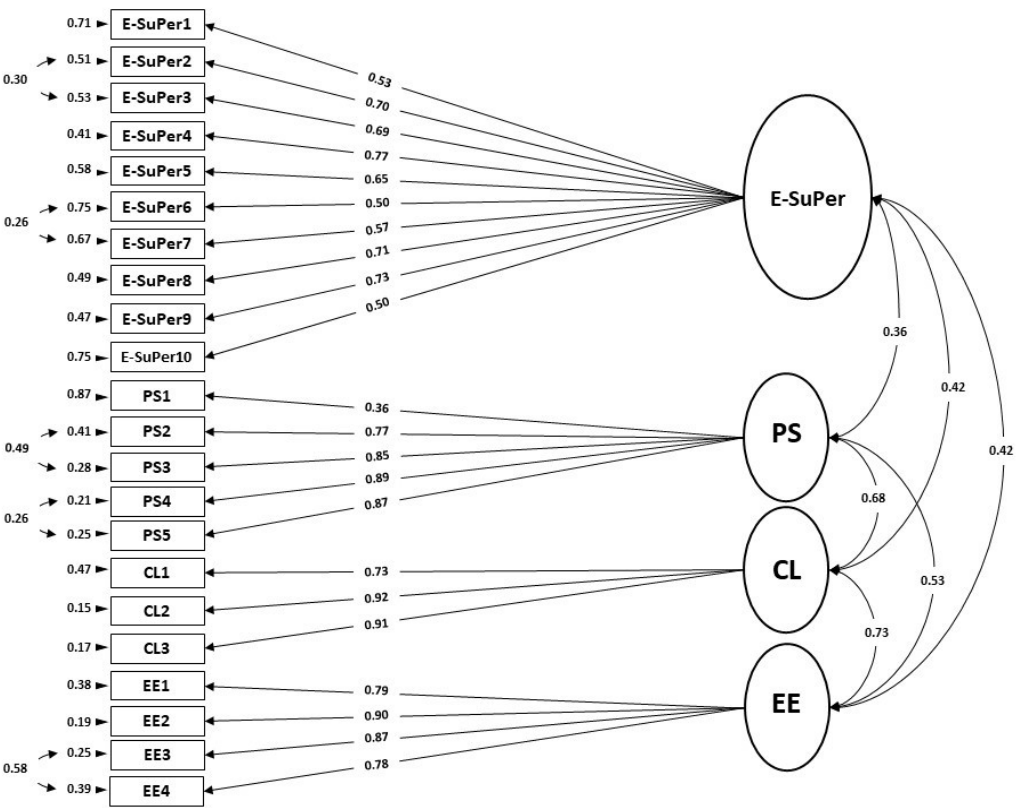
Figure 4. Path diagram and the coefficient for the four-factor CFA structure of E-SuPer–PS–CL–EE ( n = 160).